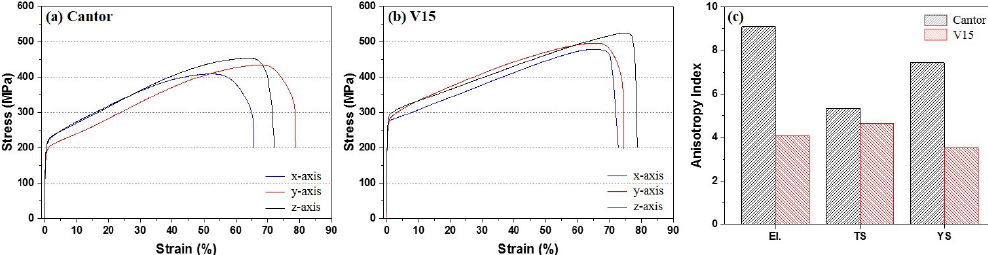
Figure 5. Tensile properties along three different loading directions of the ( a ) Cantor and ( b ) V15 HEAs. ( c ) Anisotropy indices ( I i ) for each tensile property of both HEAs. I i = (standard deviation of i x , i y , and i z )/(average of i x , i y , and i z ) × 100, where i = YS, TS, and El. and x , y , and z are the loading directions. Table 4. Tensile properties of Cantor and V15 HEAs.